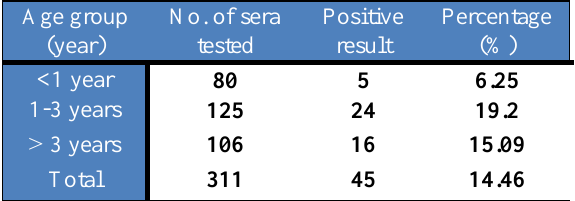
Table, 7: Percentage of sheep and goat brucellosis by using mRBT according to age group.